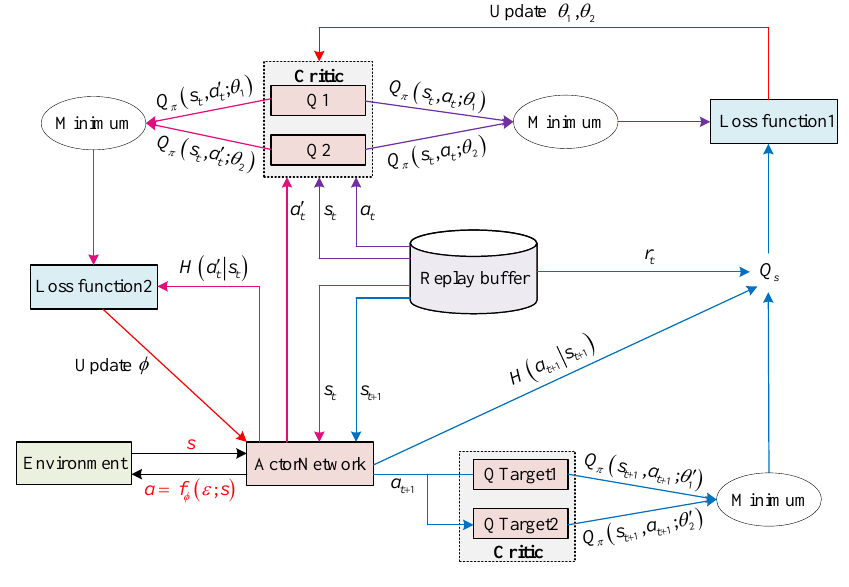
Figure 3. Structure diagram of